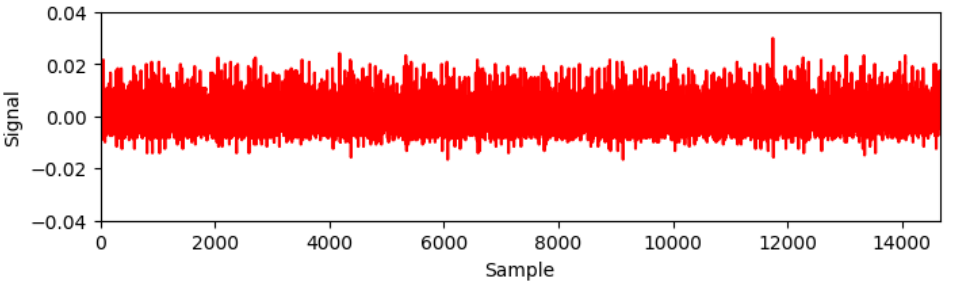
Figure 6: The relevant part (i.e. the first three rounds of AES) of an acquired EM trace. It is difficult to provide an exact comparison with existing attacks on similar